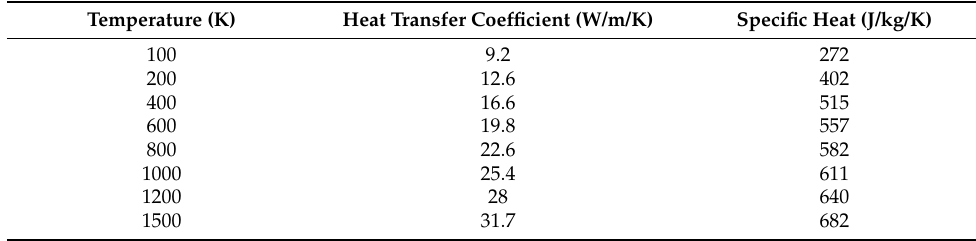
Table 2. The temperature-related physical parameters of stainless steel 304